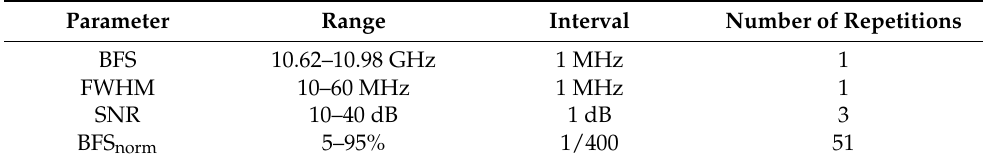
Figure 4. A BGS sample is obtained according to Equation (13). Table 1. Details of the noisy BGSs used to train and test the proposed method. The starting frequency, the ending frequency, and the frequency scanning step of BGS were 10.6 GHz, 11.00 GHz and 2 MHz, respectively.